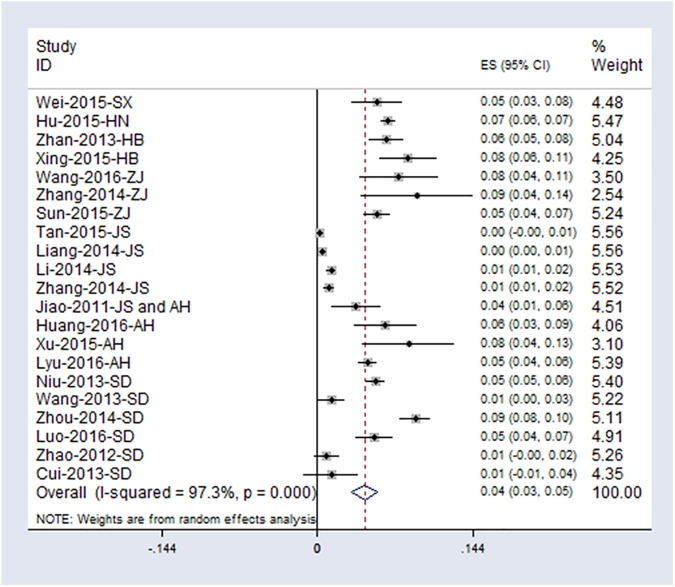
Forest plot of seroprevalence for total antibodies against SFTSV in healthy population.The middle point of each line indicates the prevalence rate and the length of line indicates 95% confidence interval of each study. Rhombus shape indicates 95% confidence interval for all studies.